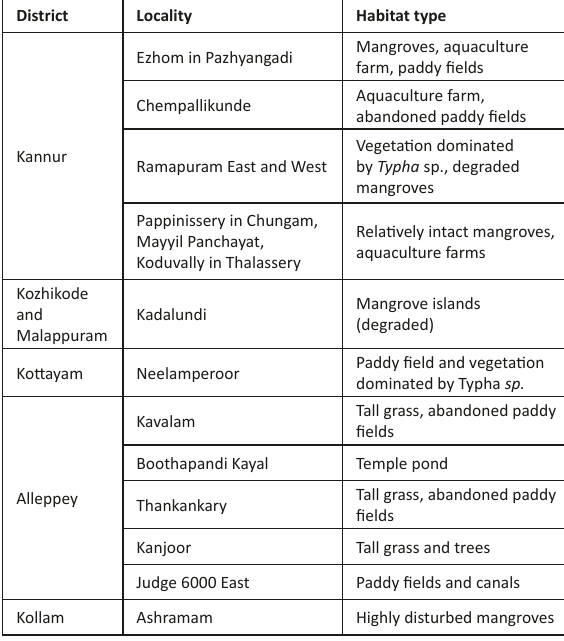
Table 1. Places surveyed where habitat observations were made and scat samples were